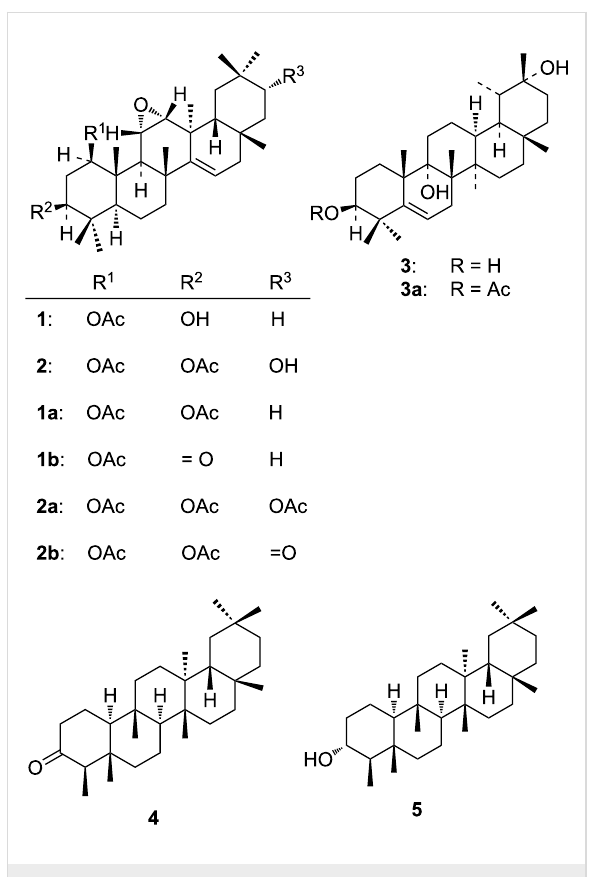
Figure 1: Structures of compounds 1 , 2 , 3 , 1a , 2a , 1b , 2b , 3a , 4 and 5